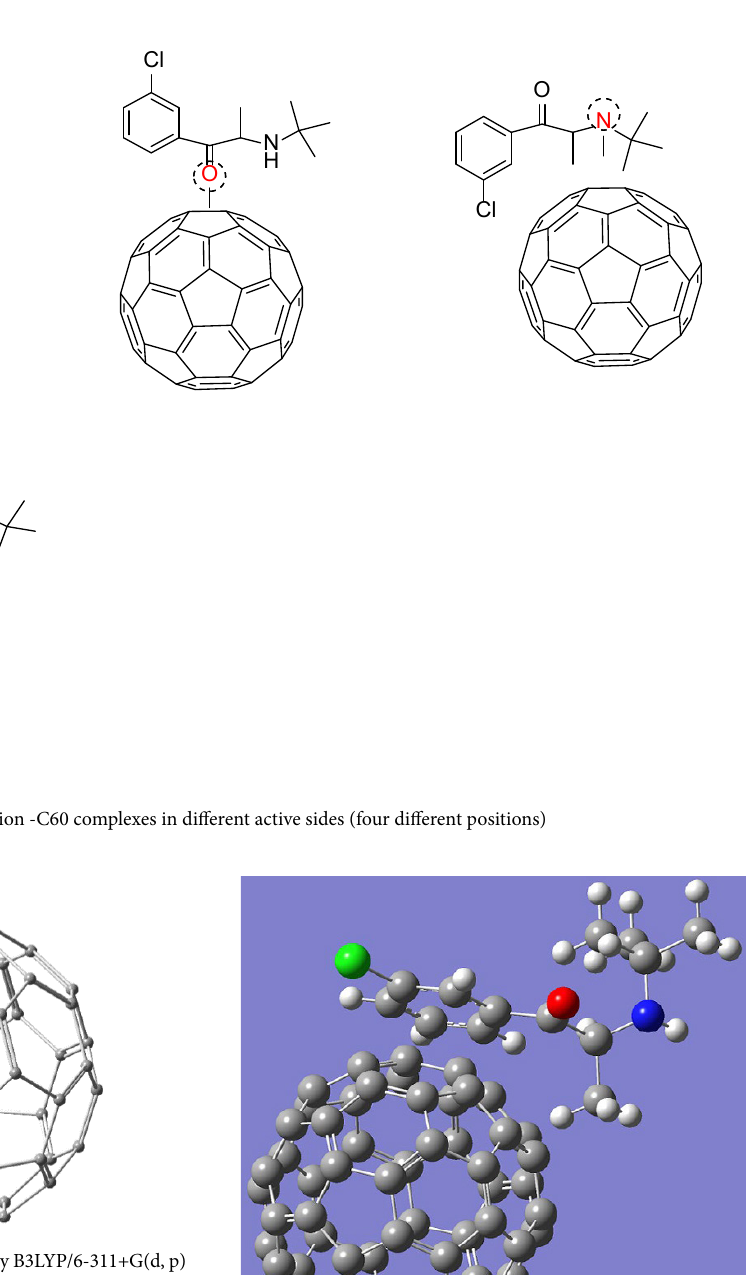
Fig. 4. Optimized structure of C60(ih) by B3LYP/6-311+G(d, p) E(-738.33kJ) Fig 4. Optimized structure of C60(ih) by B3LYP/6-311+G(d, p) E(-738.33kJ)